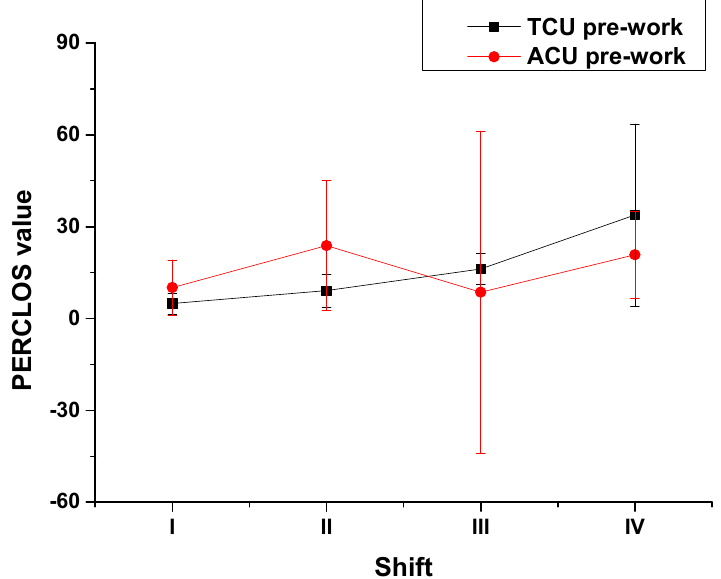
Figure 5. Pre-shift PERCLOS values of ATCOs by shift and work type.